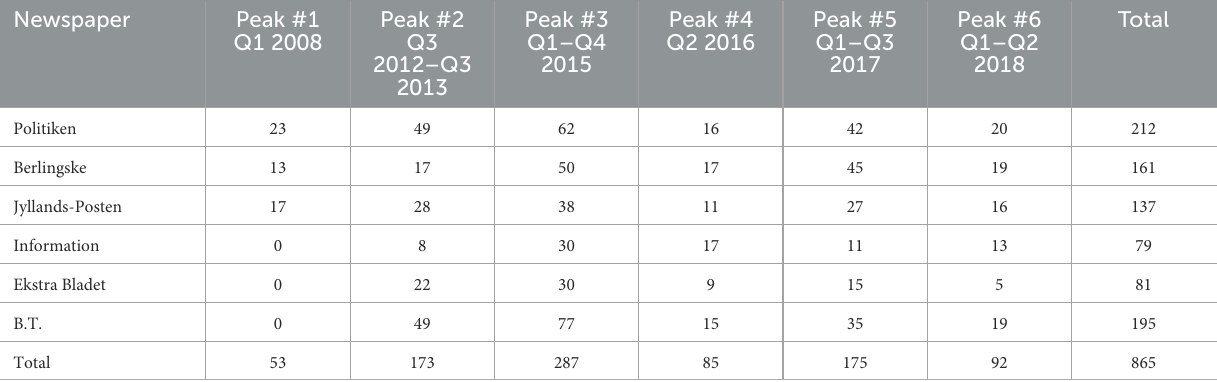
TABLE 1 Six peak periods and the number of articles published about HPV vaccination.